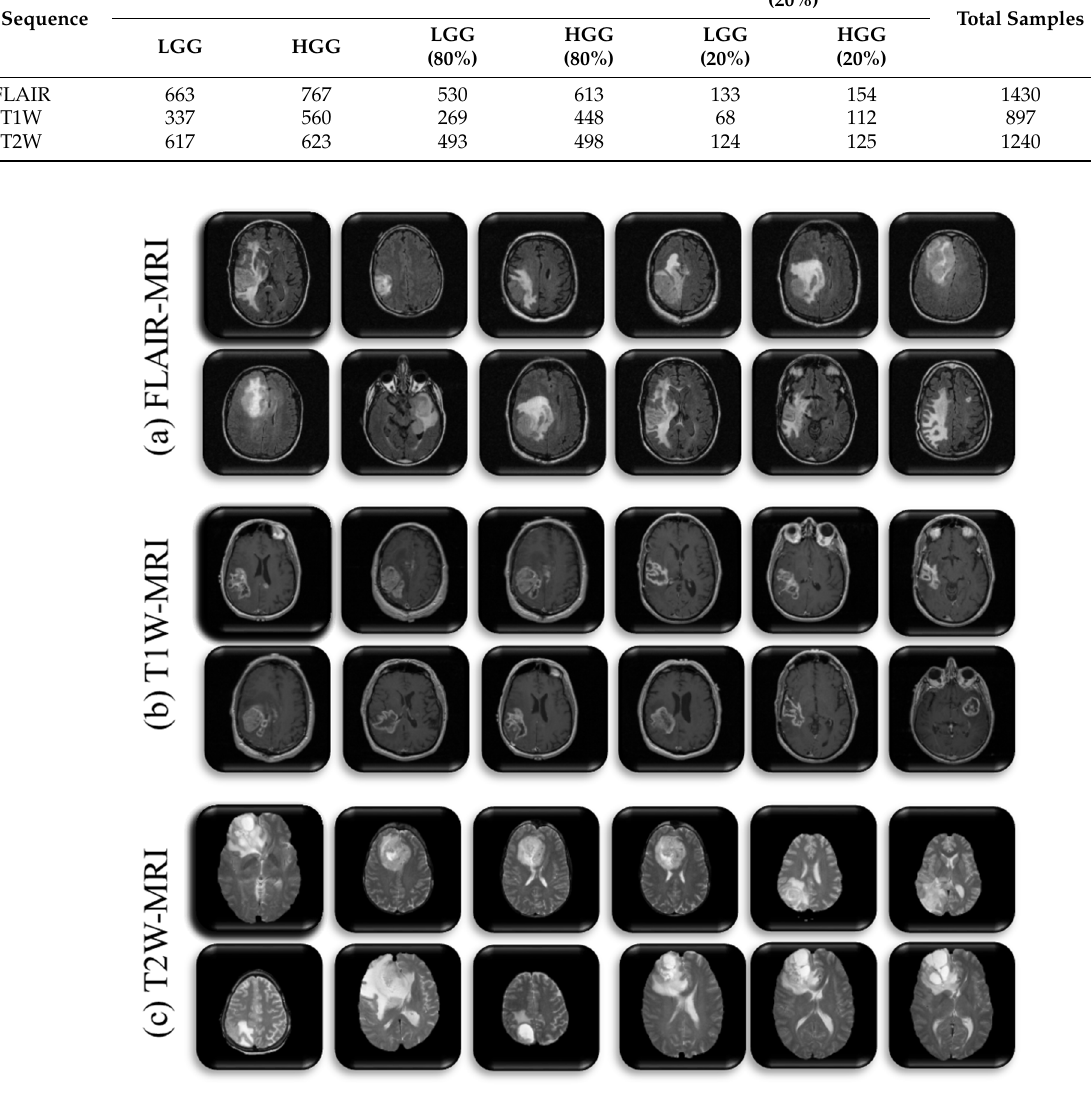
Figure 3. Sample images of three MRI sequences dataset, ( a ) T1W, ( b ) T2W, ( c ) FLAIR.